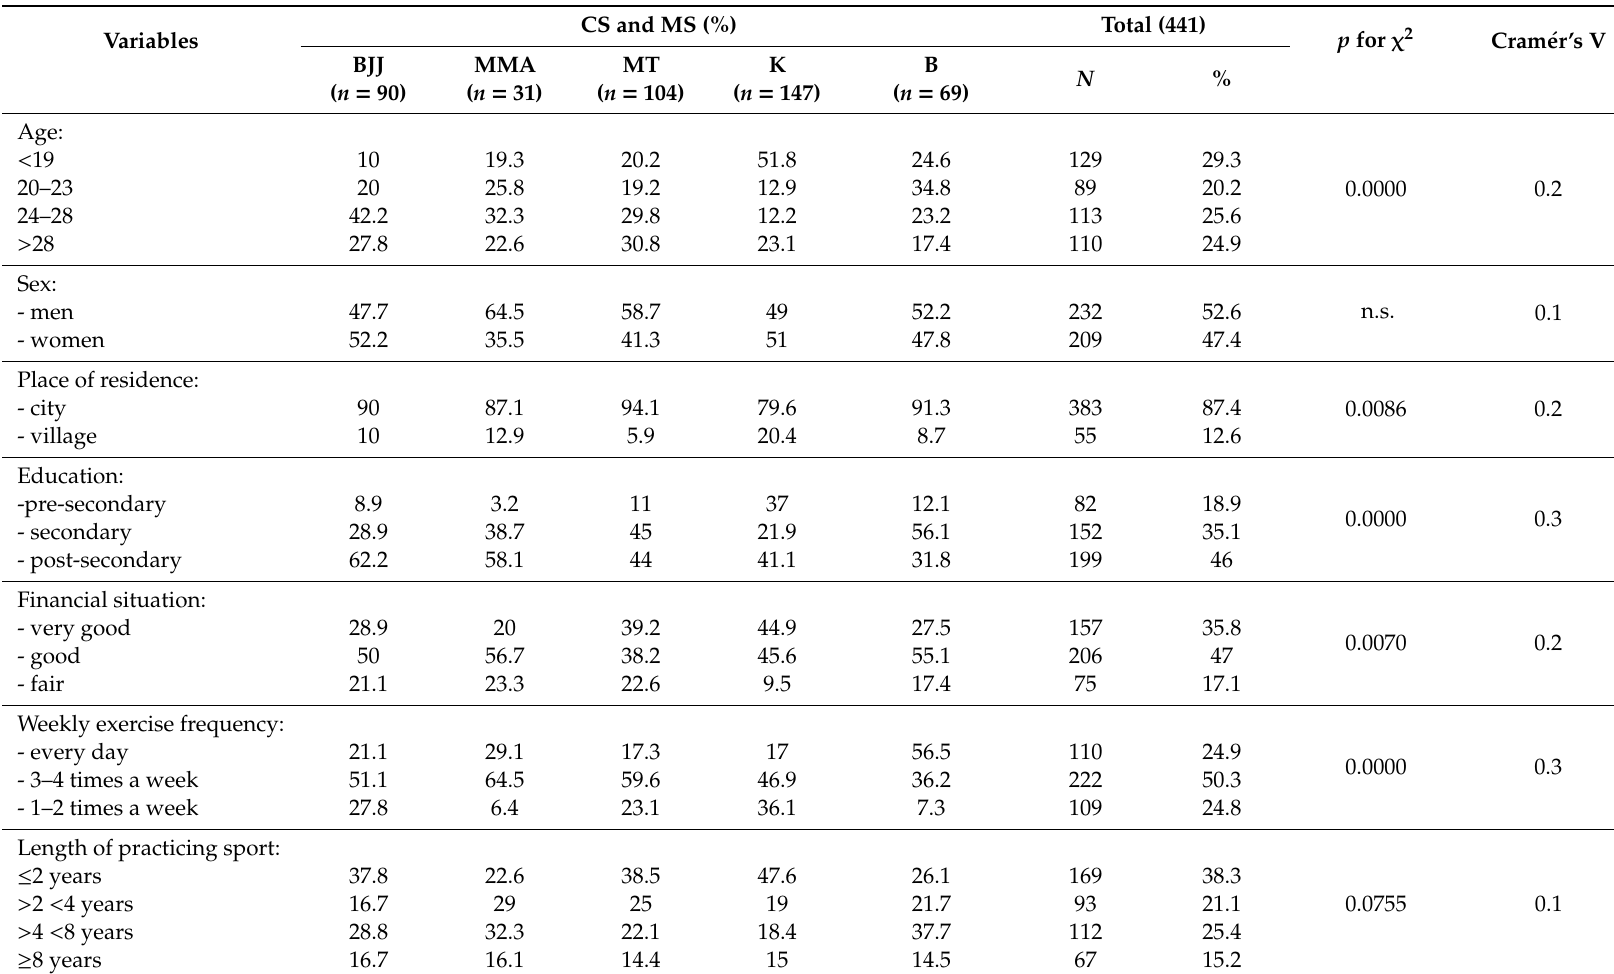
Table 1. Characteristics of people who practice combat sports (CS) and MA (independence χ 2 test, and Cram é r’s V). CS and MS Variables